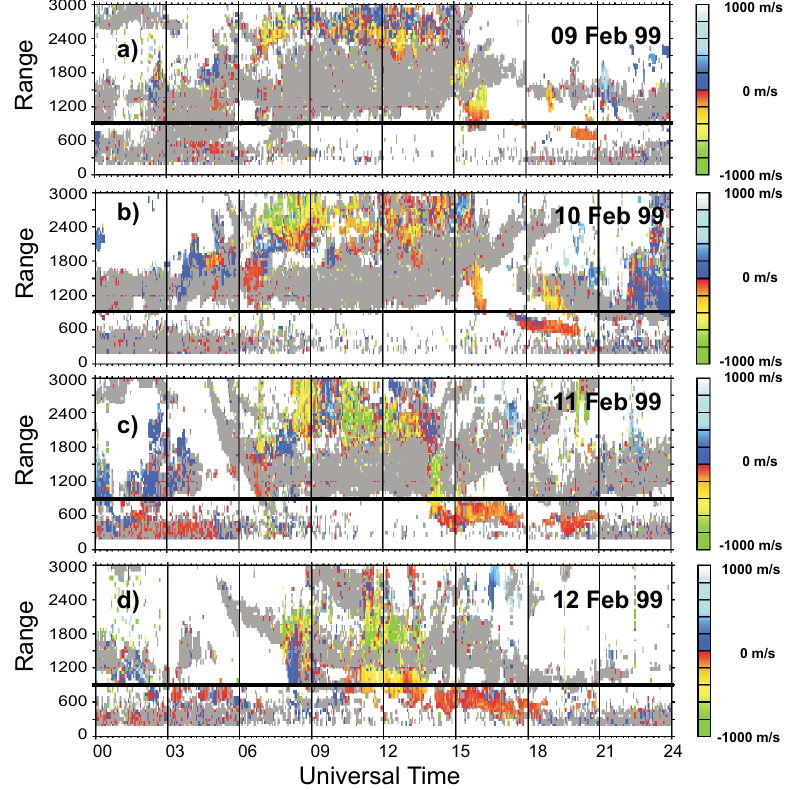
Fig. 2. (a)–(d) Doppler velocity measured by the CUTLASS Hankasalmi radar in beam 5 on 9–12 February 1999. Horizontal solid line at 900km shows the range corresponding to the area where measurements were made by the EISCAT incoherent scatter radar. The gray color denotes the ground scatter. MLT = UT +